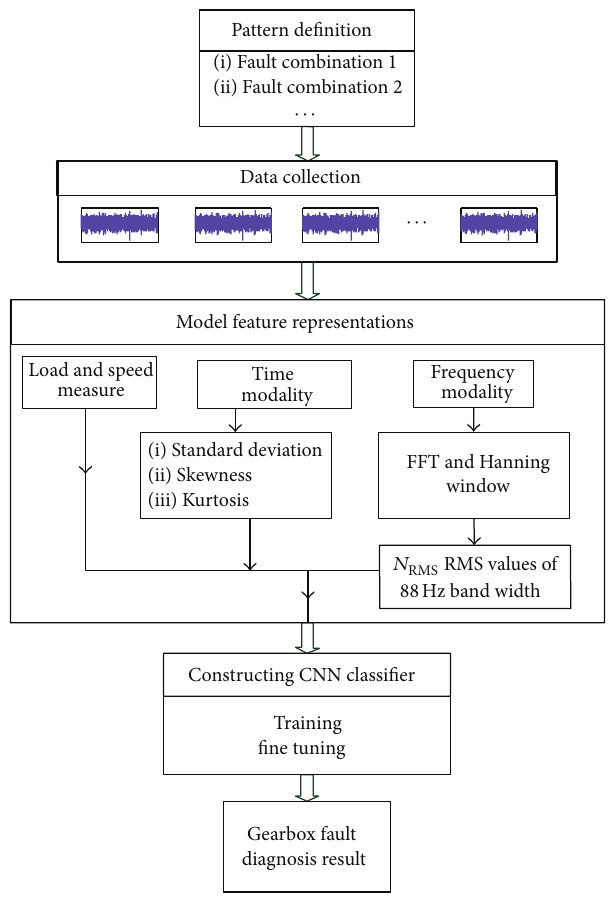
Figure 5: Training and testing process block diagram. Table 6: Parameters tuning of the architecture of